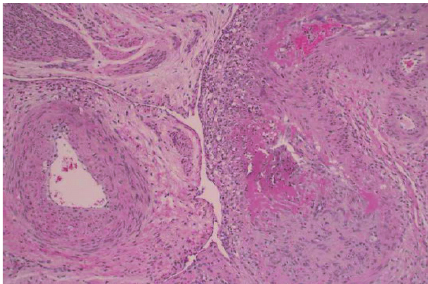
Figure 2: Vessels in the myometrium. Uninvolved vessel on the left: vasculitis involves vessels on the right. Normal myometrium upper left. Vasculitis characterized by an inflammatory infiltrate, mostly neutrophilic, involving vessel wall with fibrinoid necrosis and thrombus [H&E ×